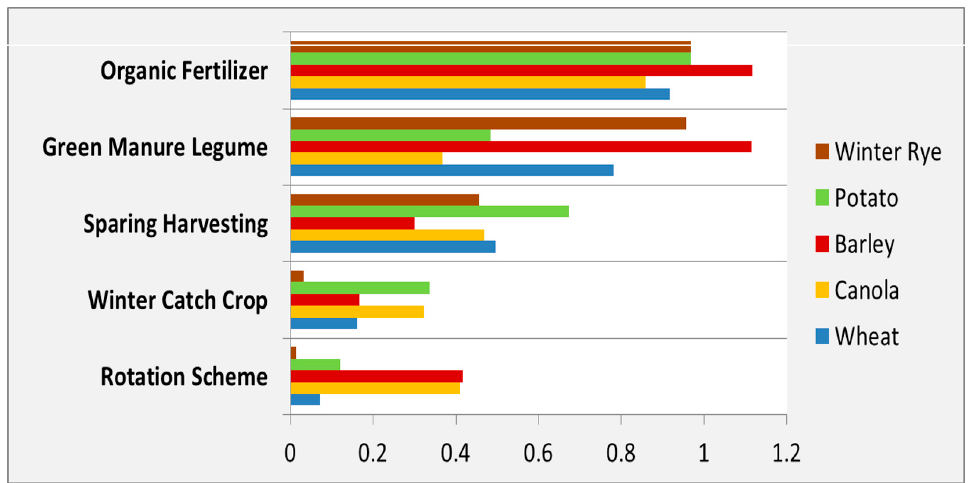
Figure 10. Comparative efficiency of tested measures (partial benefit/total benefit).